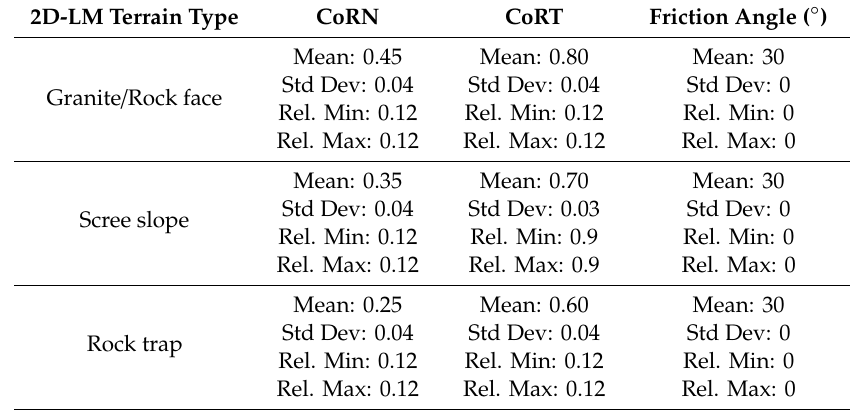
Table 2. Summary of Coe ffi cients of Restitutions (COR) used for the 2D-LM numerical modelling. 2D-LM Terrain Type